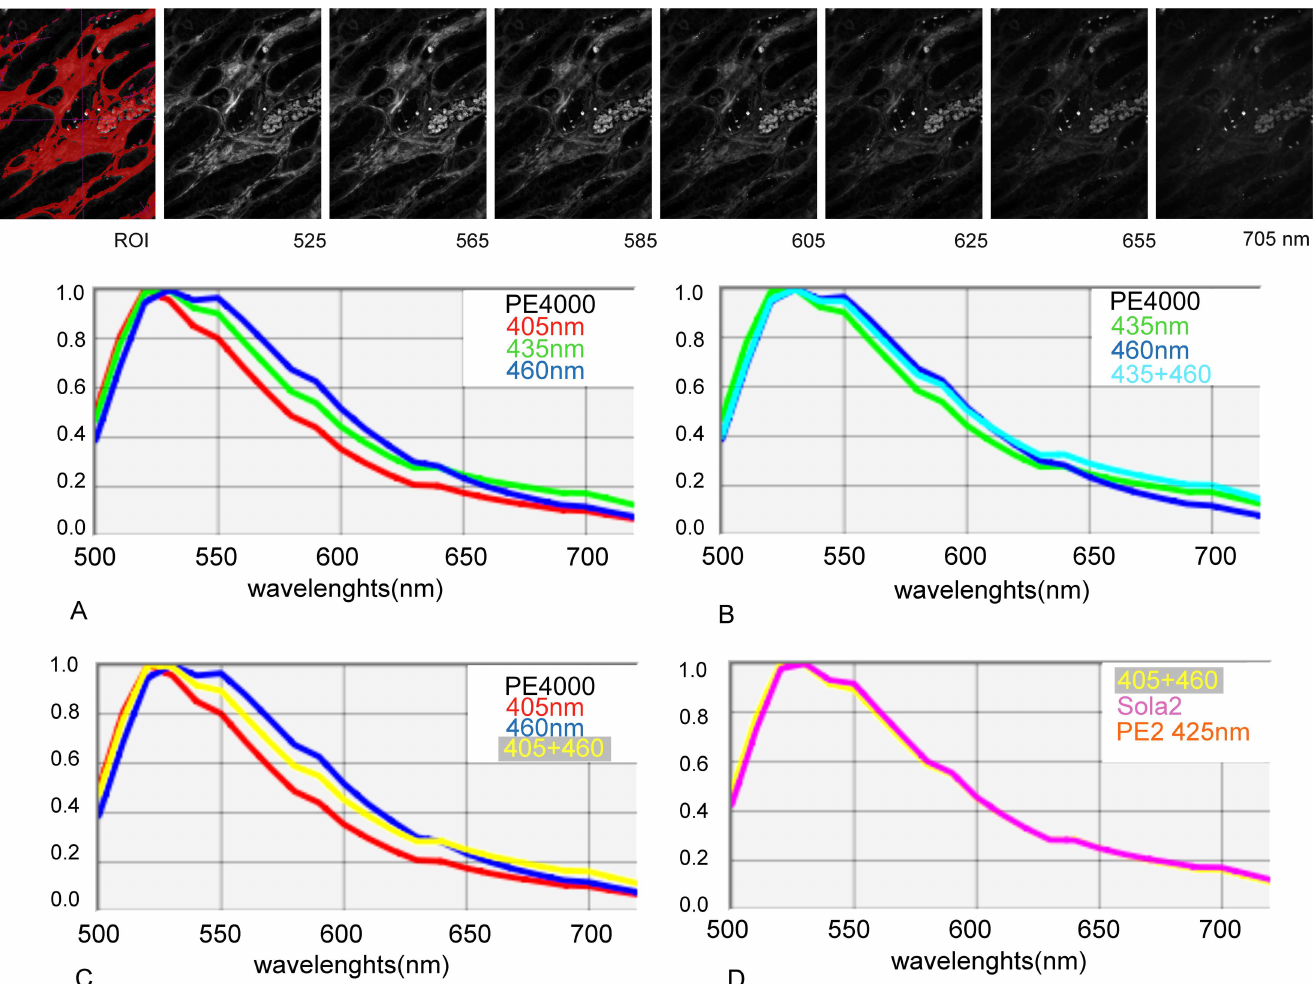
Fig 5. Comparison of the spectraof autofluorescence of FFPE kidney tissueunderillumination withPE4000 at 405nm;435nm460nm or combinations;PE2 425nmor Sola 2. Top panel: An example of the autofluorescence intensityimagesunder illumination with 405+460nmis shown for the indicatedemission wave lengthswhich correspondto the peak of emissionof the studiedQdots. ROI shows a typical thresholdedregionof interest selectedfor quantification of the intensityof autofluorescence. Graphs :The spectra of autofluorescence were found to be fairly similarbetween500 and 720nm.However the level of autofluorescence between 530 to 650nmincreases with the excitation wave lengthwith PE4000 (A&C).SOLA2,PE2 425 & PE4000 405+460nmlead to similarautofluorescence spectra (D).